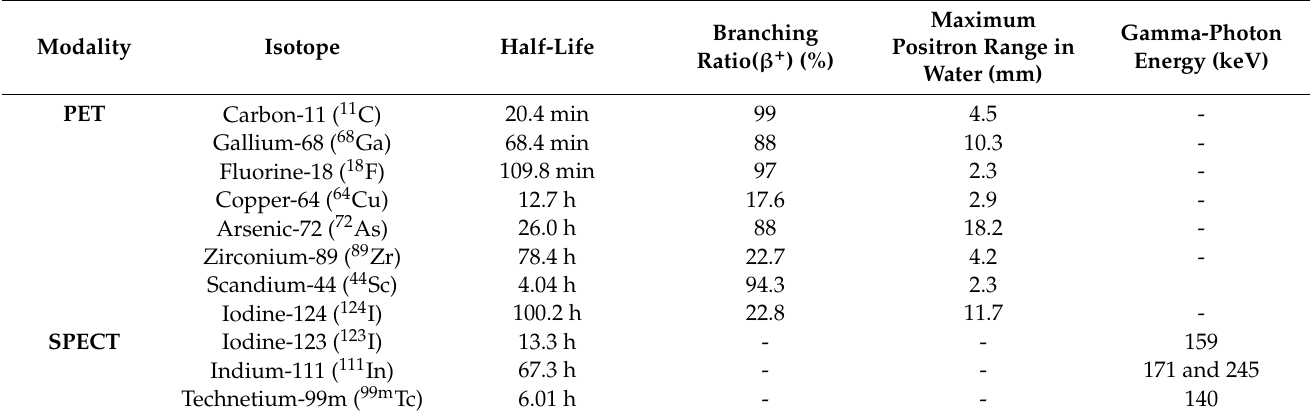
Table 1. Physical properties of common radionuclides for molecular imaging